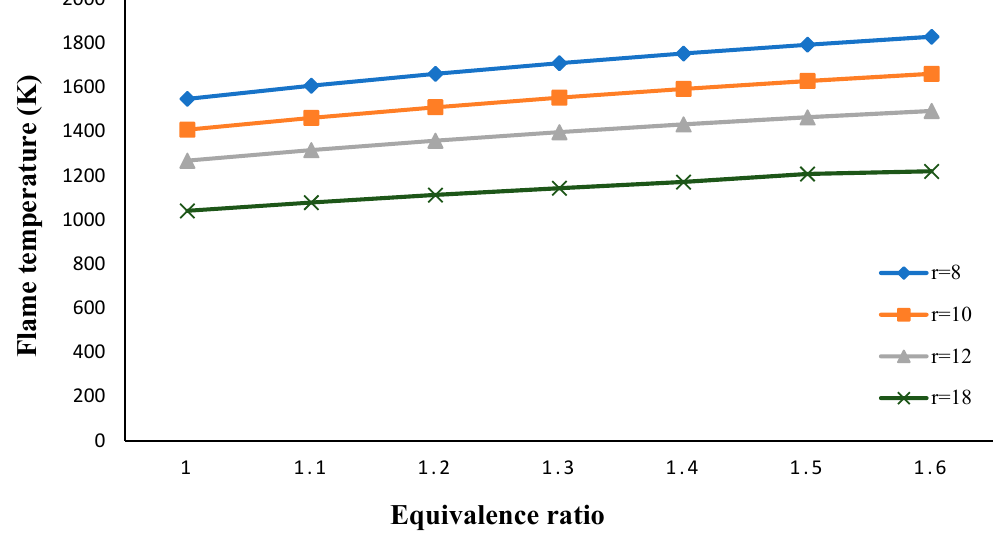
Figure 10. Flame temperature against the effective equivalence ratio ( φ u ) considering several lycopodium radii.